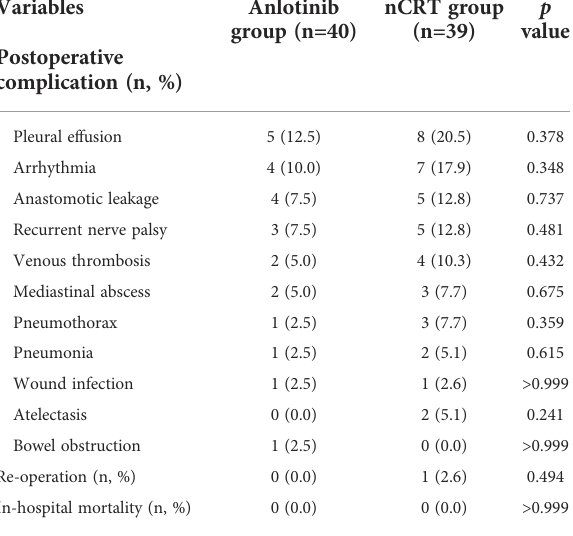
TABLE 6 Postoperative complications.